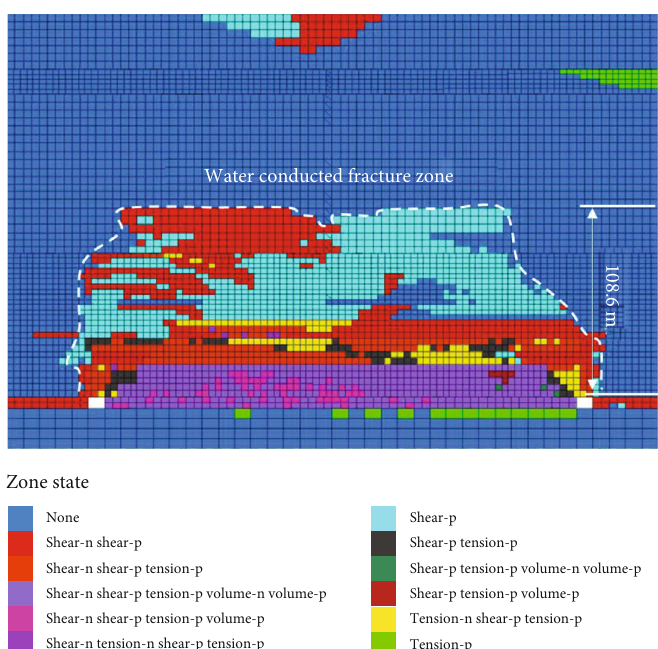
Figure 5: Distribution characteristics of overburden plastic zone in the middle of the model ( Y = 200 m plane).